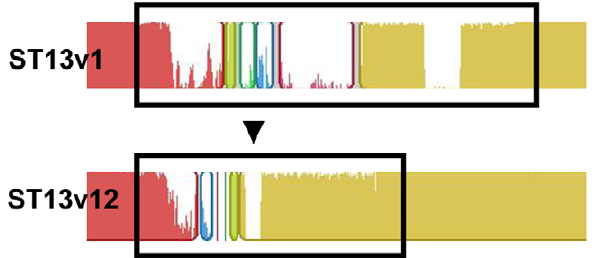
Figure 4. Illustration of a region transferred by HGT. MAUVE alignment of the genome region of ST13v1 and ST13v12 corresponding to NG14 (containing RDP N, O and P). Colored blocks represent NG14 regions that are homologous; a similarity plot inside each block portrays the average degree of conservation in that region. Black boxes bound sites displaying the most obvious differences between the 57 Kb NG14 region of ST13v1 and the 34 Kb NG14 region of ST13v12.